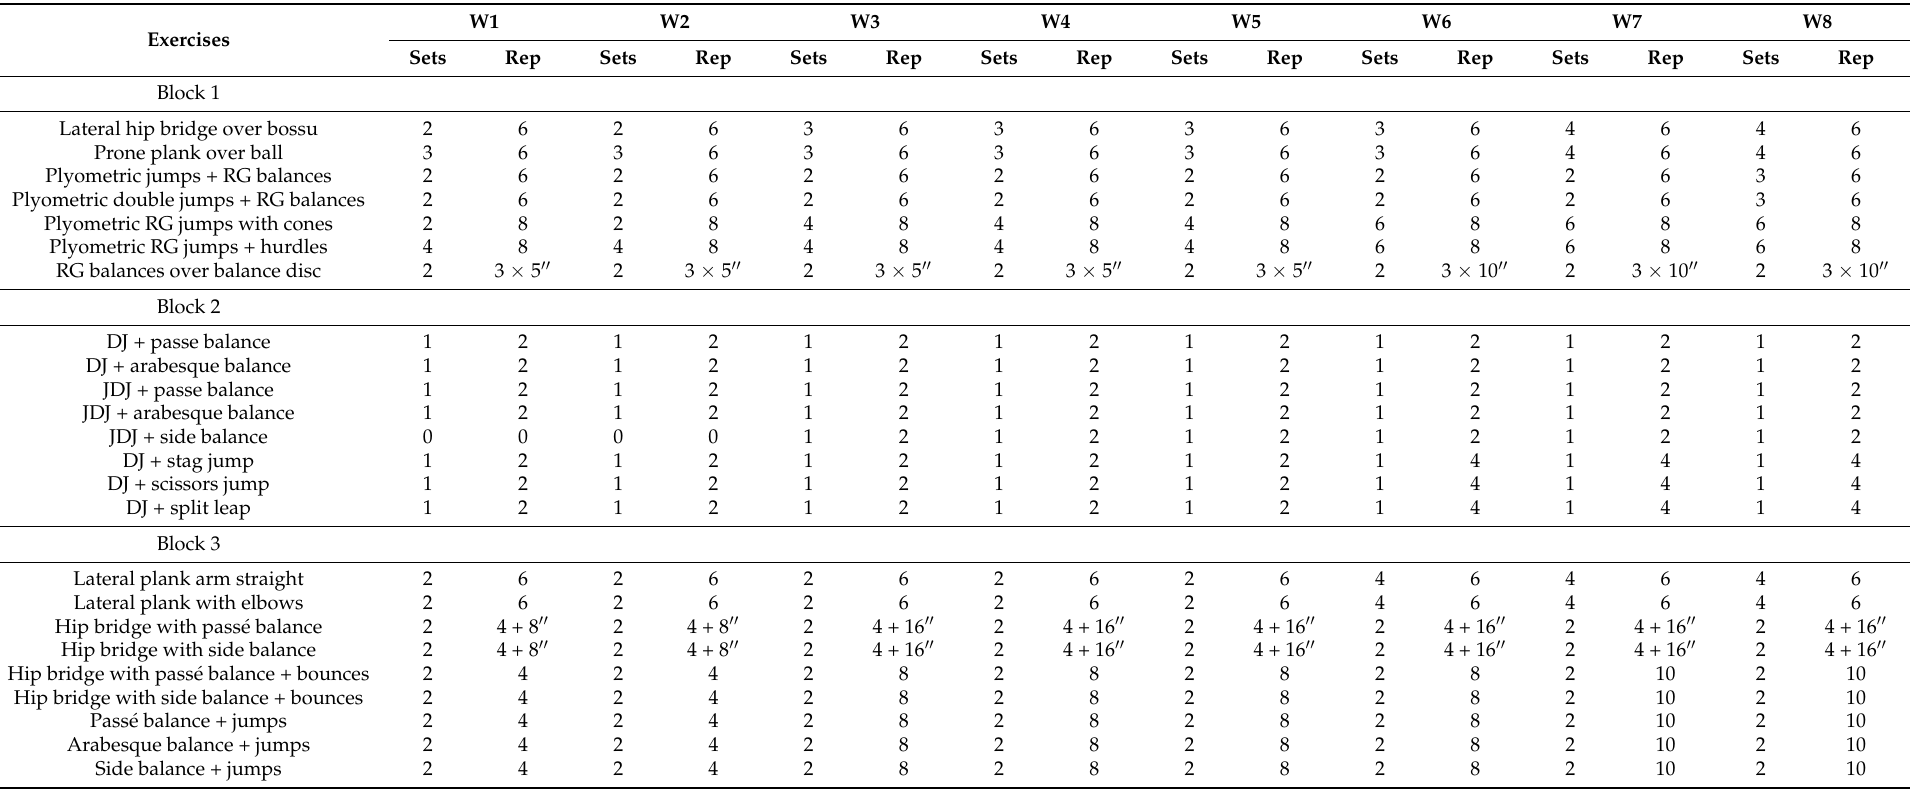
Table 2. Overview of the 8-week functional CST